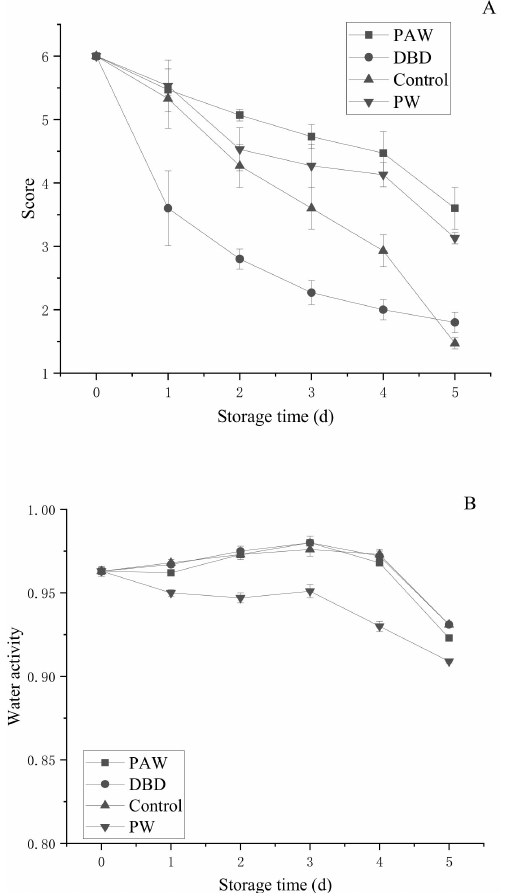
Figure 4. Changes in the ( A ) sensory evaluation and ( B ) water activity of the button mushroom in different treatment